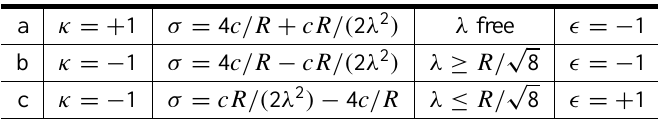
Parameters for uniform ’(t)